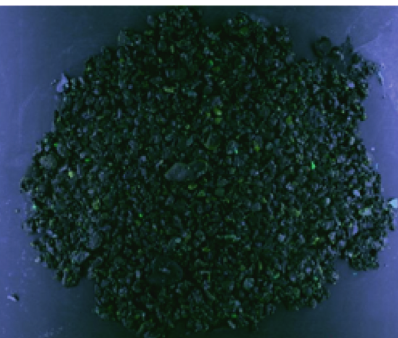
Figure 3: Image binarization diagram. Denoise by Gaussian filter